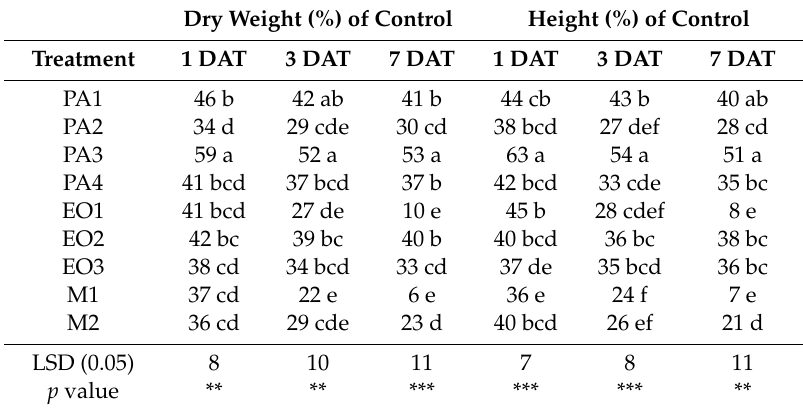
Table 3. Dry weight and height of L. rigidum plants as a ff ected by the application of the natural herbicides at 1, 3 and 7 days after treatment (DAT). Dry weight and height values of L. rigidum plants was expressed as % of